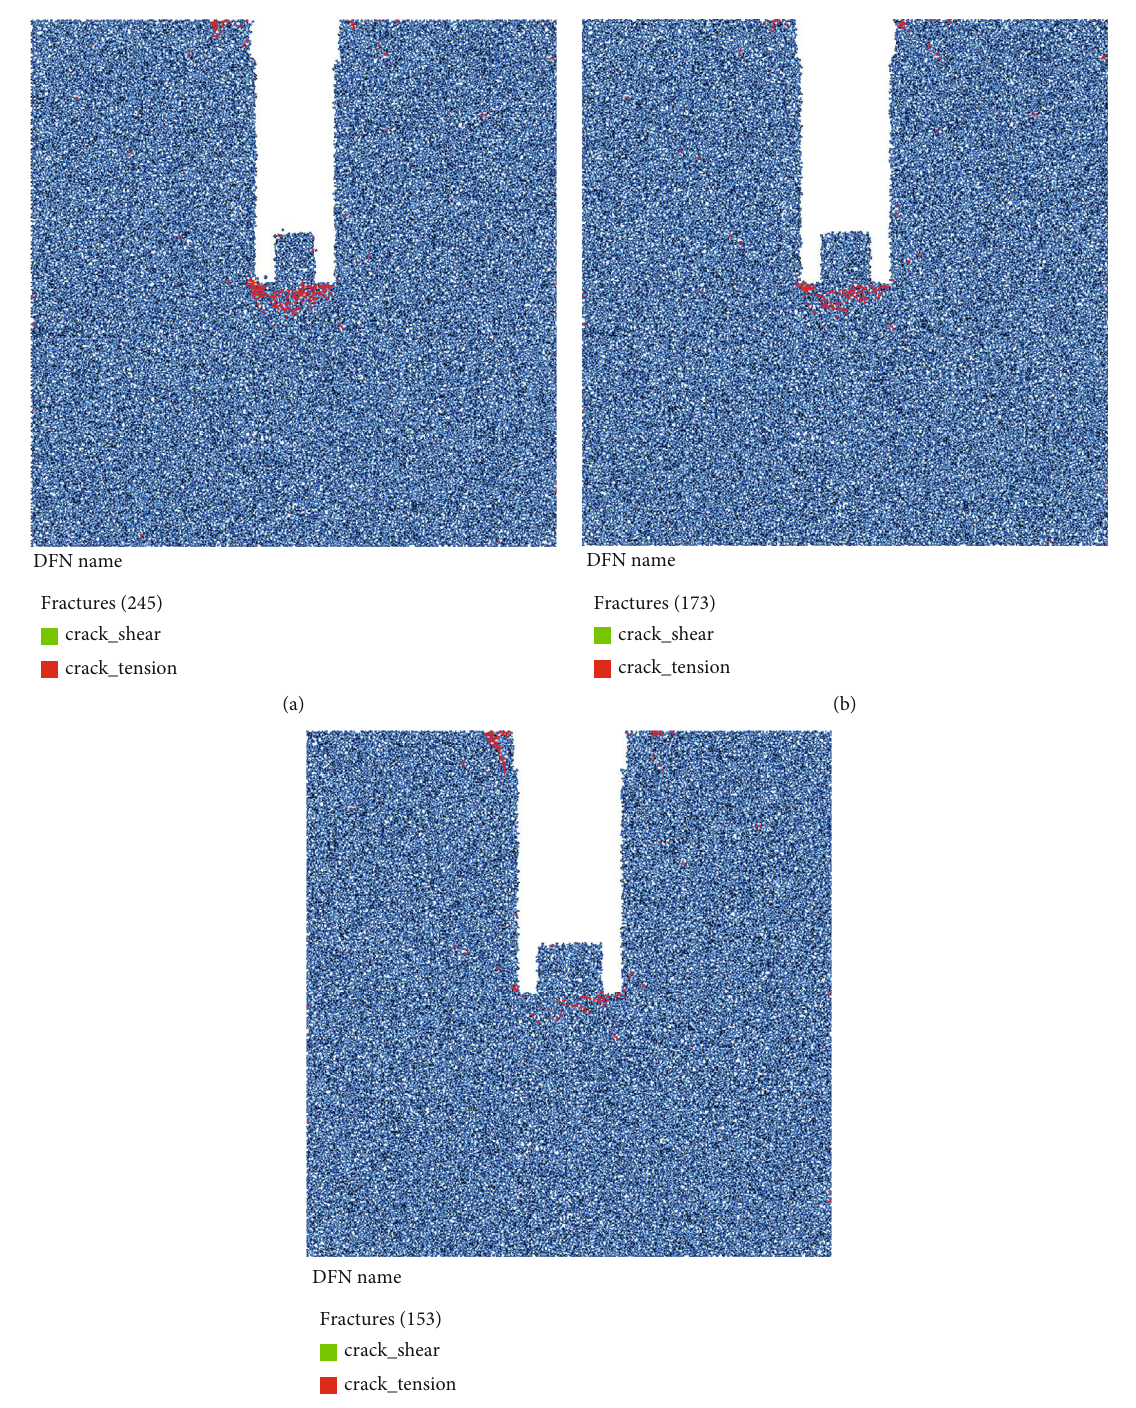
Figure 7: Typical crack distribution diagrams of the model under di ff erent core diameters. (a) D = 8 : 00 mm . (b) D = 10 : 00 mm . (c) D = 13 : 00mm